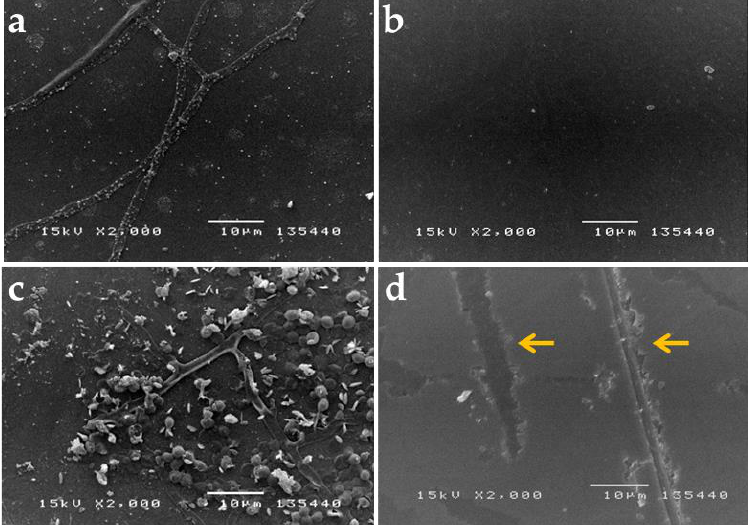
Figure 5. SEM micrographs of glass after 28 days of the test: ( a ) fungal growth on glass after 28 days; ( b ) sample photo taken after 28 days of the alcohol-purge test; ( c ) glass sample after six months of testing showing fungal spores; ( d ) glass sample after six months of testing showing the glass corrosion caused by